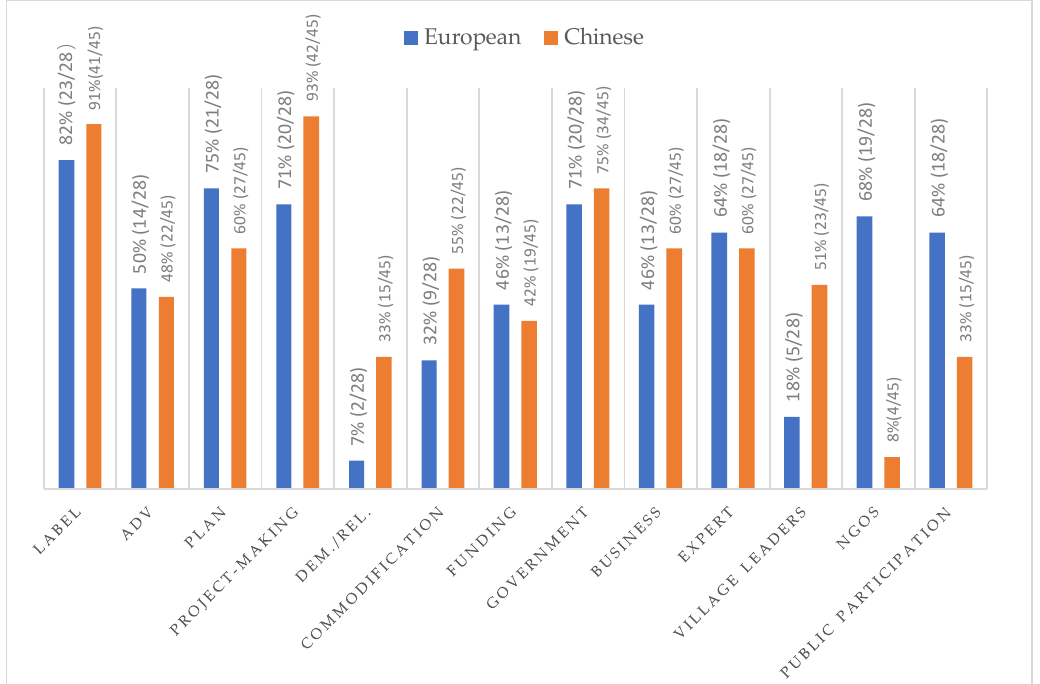
Figure 3. Main themes and percentages of case studies based on comparison between the European and Chinese contexts. (Authors’ elaboration.) Note: ADV stands for “advertisement”; DEM./REL stands for “demolition/relocation”; NGOS stands for “non - governmental organization”.